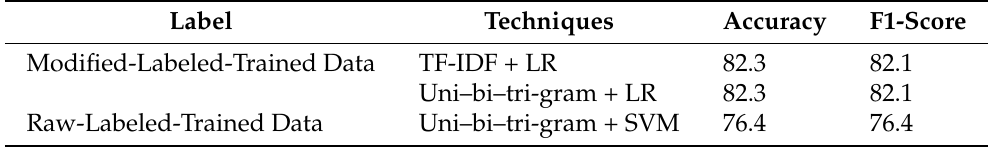
Table 11. Comparison of highest accuracy and F1-score on real-time